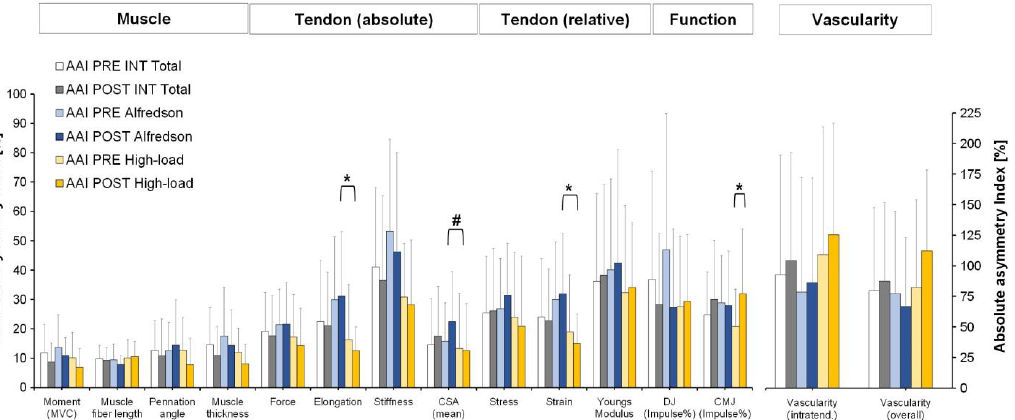
Figure 2. Absolute asymmetry index (AAI) for muscular, tendinous (absolute), tendinous (relative) and functional (i.e., jump performance) parameters of the plantar flexor muscle-tendon unit and for Achilles tendon vascularity for both intervention groups at baseline (AAI PRE INT TOTAL) (n = 24) and post exercise (AAI POST EXP) (n = 24), PRE (AAI PRE high-load) and post 12 weeks of specific high-loading exercise (AAI POST high-load) (n = 13) and PRE (AAI PRE Alfredson) and post 12 weeks of specific eccentric exercise (AAI POST Alfredson) (n = 11). Data are presented as mean ± standard deviation (SD). MVC = maximum voluntary isometric plantar flexor muscle contraction; CSA = cross-sectional area of Achilles tendon; intratend. = intratendinous; overall = intratendinous and paratendinous vascularization; CMJ = counter movement jump; DJ = drop jump; Impulse % = impulse percent of total; * significant difference between AAI ( p < 0.05); # significant difference between comparisons of AAI PRE to POST differences ( p < 0.05).